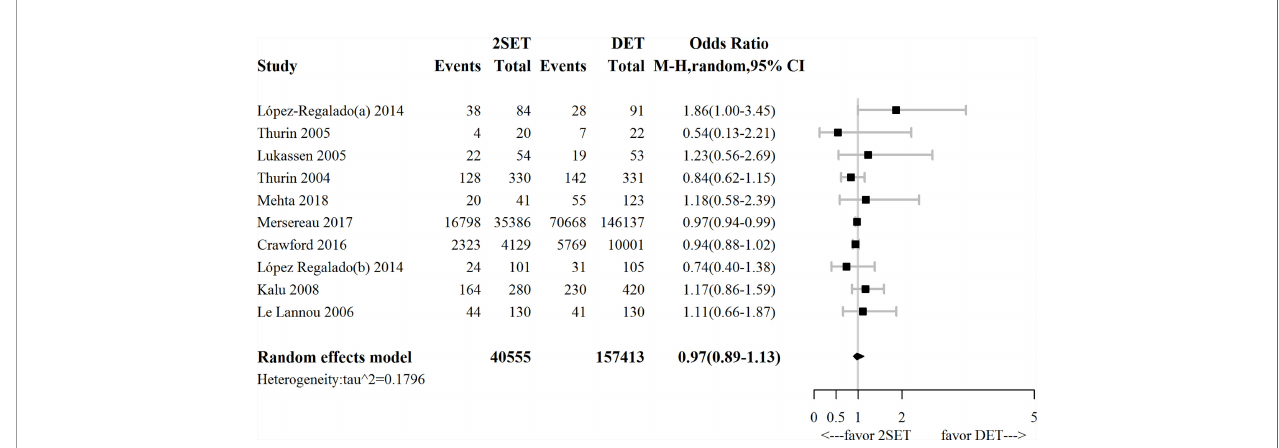
FIGURE 2 | Forest plot comparing cumulative live birth rate after two consecutive cycle of single embryo transfer (2SETs) and one cycle of double embryo transfer (DET).